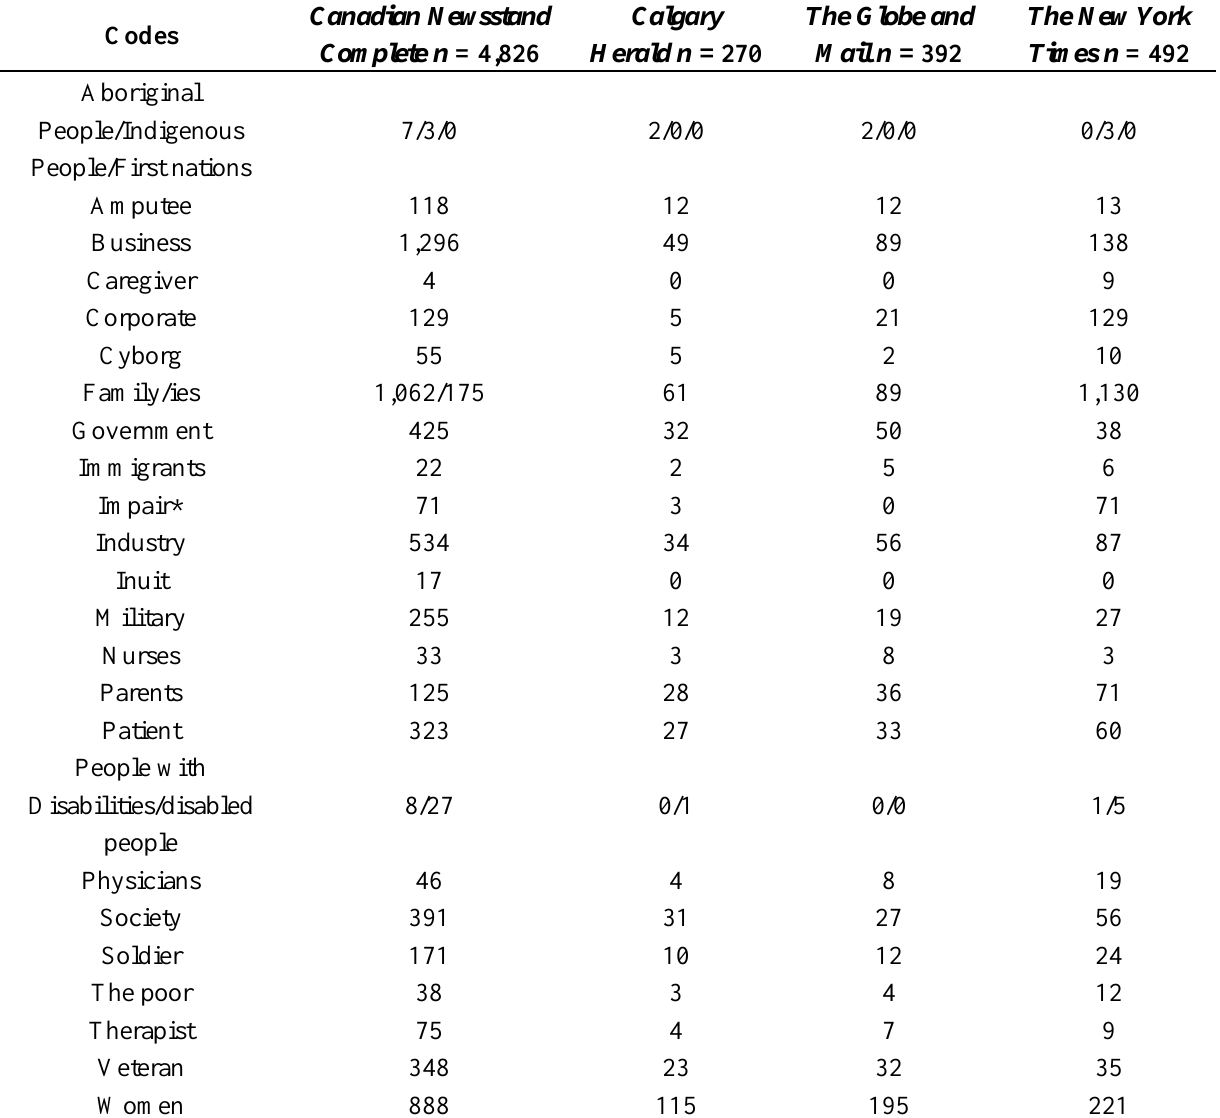
Table 1. Mentioning of groups in the newspaper coverage of